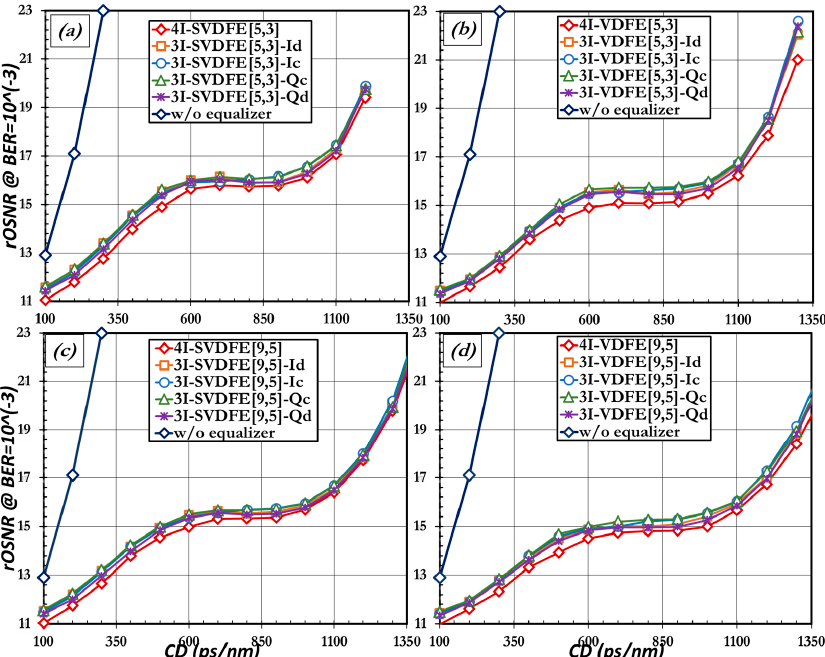
Figure 8. Required OSNR performance of comparison between the joint single-ended configurations (4I-) and the partially-joint three-input ones (3I) for the cases of ( a ) SVDFE[5,3]; ( b ) VDFE[5,3], ( c ) SVDFE[9,5]; and ( d ) VDFE[9,5].